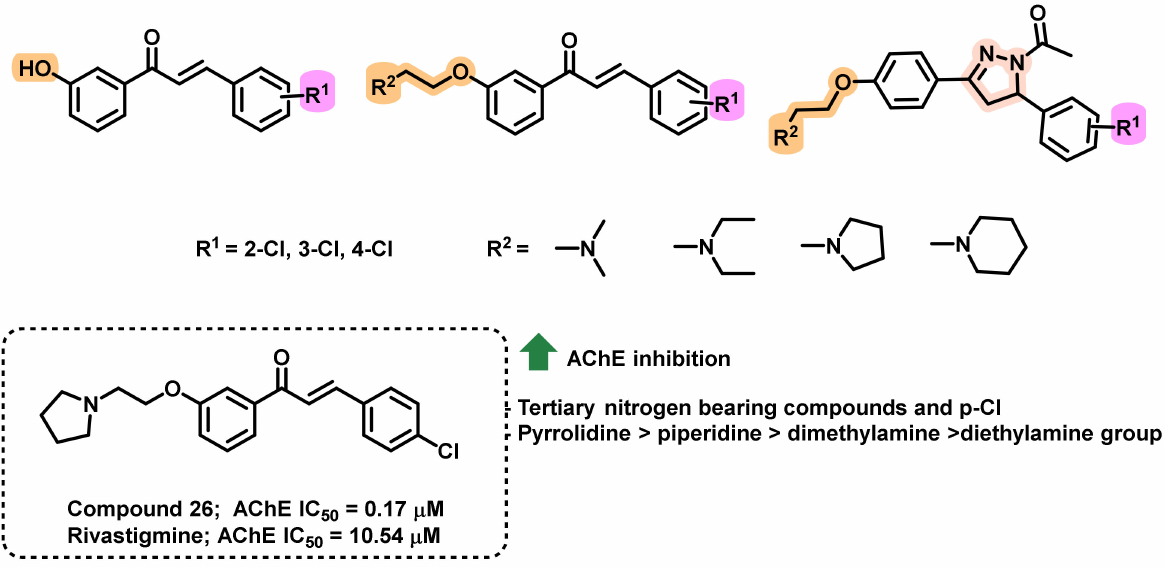
Figure 24. Chlorochalcones with tertiary amine side